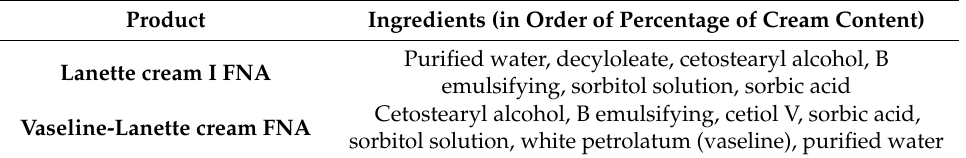
Table 1. Ingredients of investigational